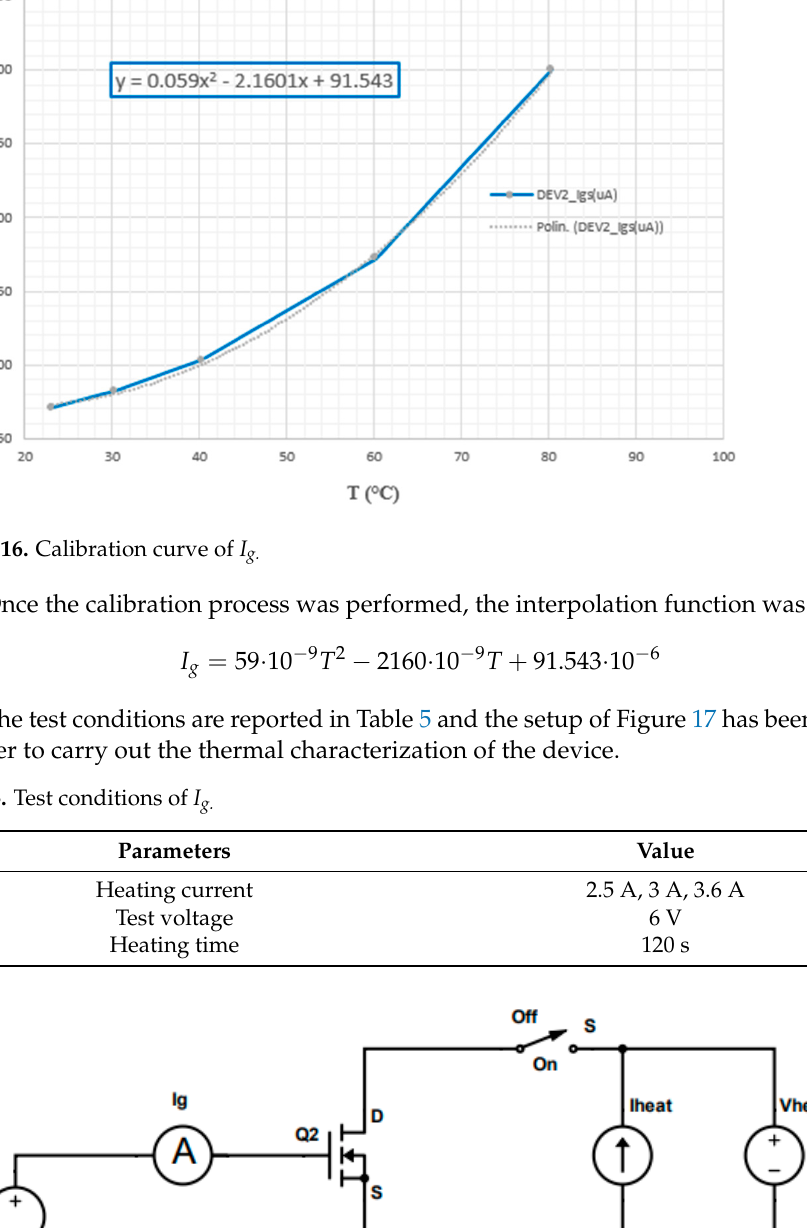
Figure 15. Calibration electrical circuit for I g.